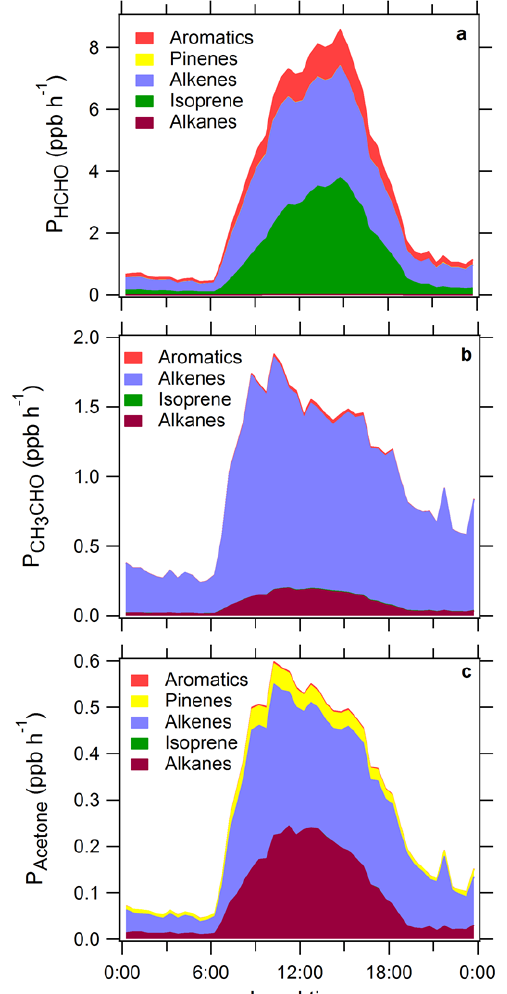
Figure 8. Averaged production of (a) formaldehyde, (b) acetalde- hyde and (c) acetone during the full control period in the simulation of